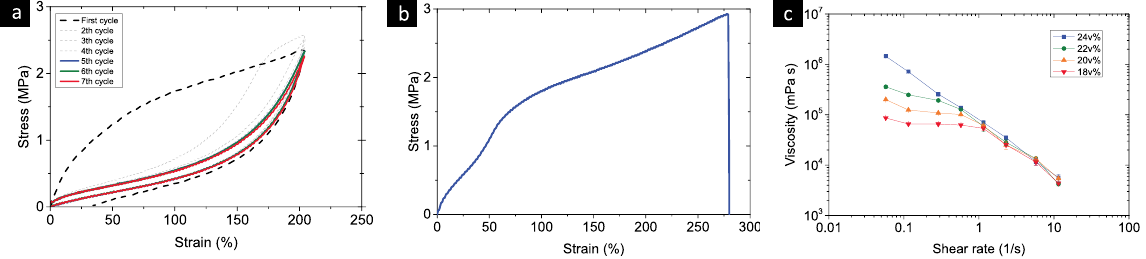
Figure 2. Mechanical properties of the Ag-PDMS composite. ( a ) The stress-strain curve and hysteresis phenomenon and ( b ) maximum rupture strain of 20 v% Ag-PDMS composite; ( c ) The viscosity curves of 18 v%, 20 v%, 22 v%, and 24 v% Ag-PDMS